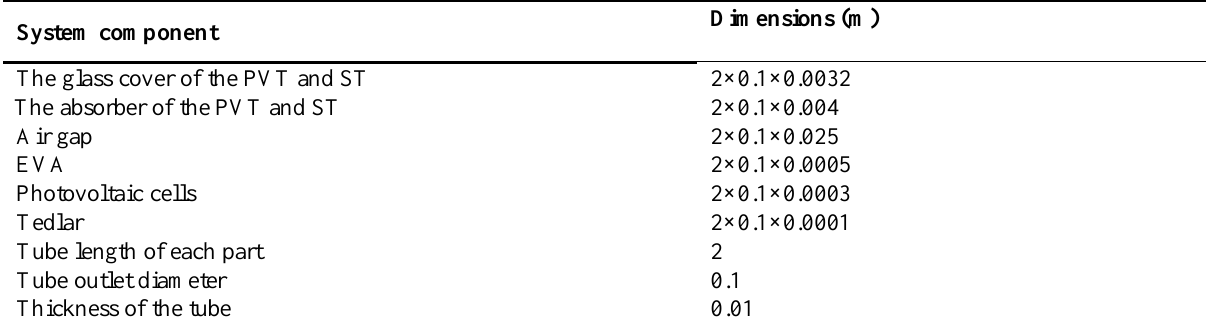
Dimensions of the PVT/ST system [4, 12]. System component